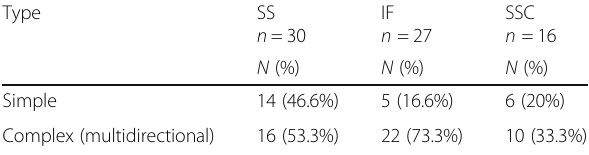
Table 2 Types of rotator cuff tear depending on tear direction